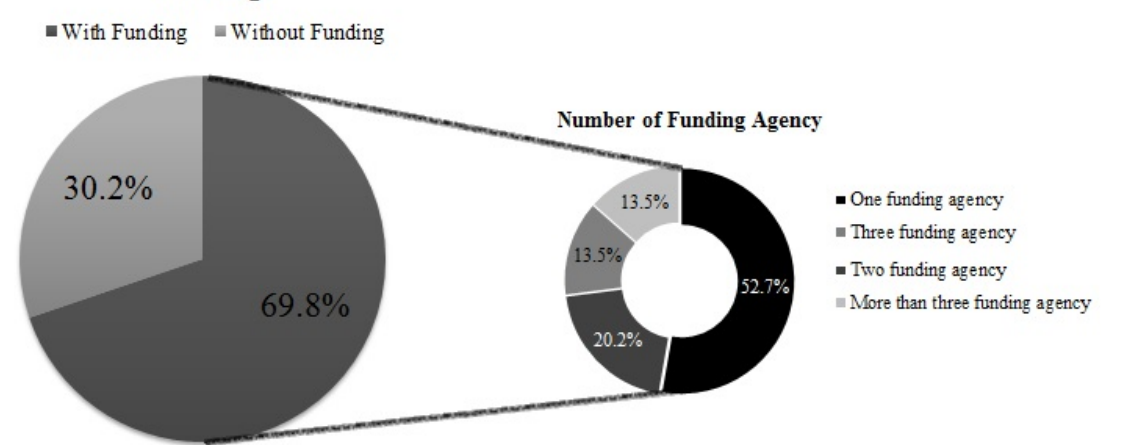
Figure 5. Funding of publications.